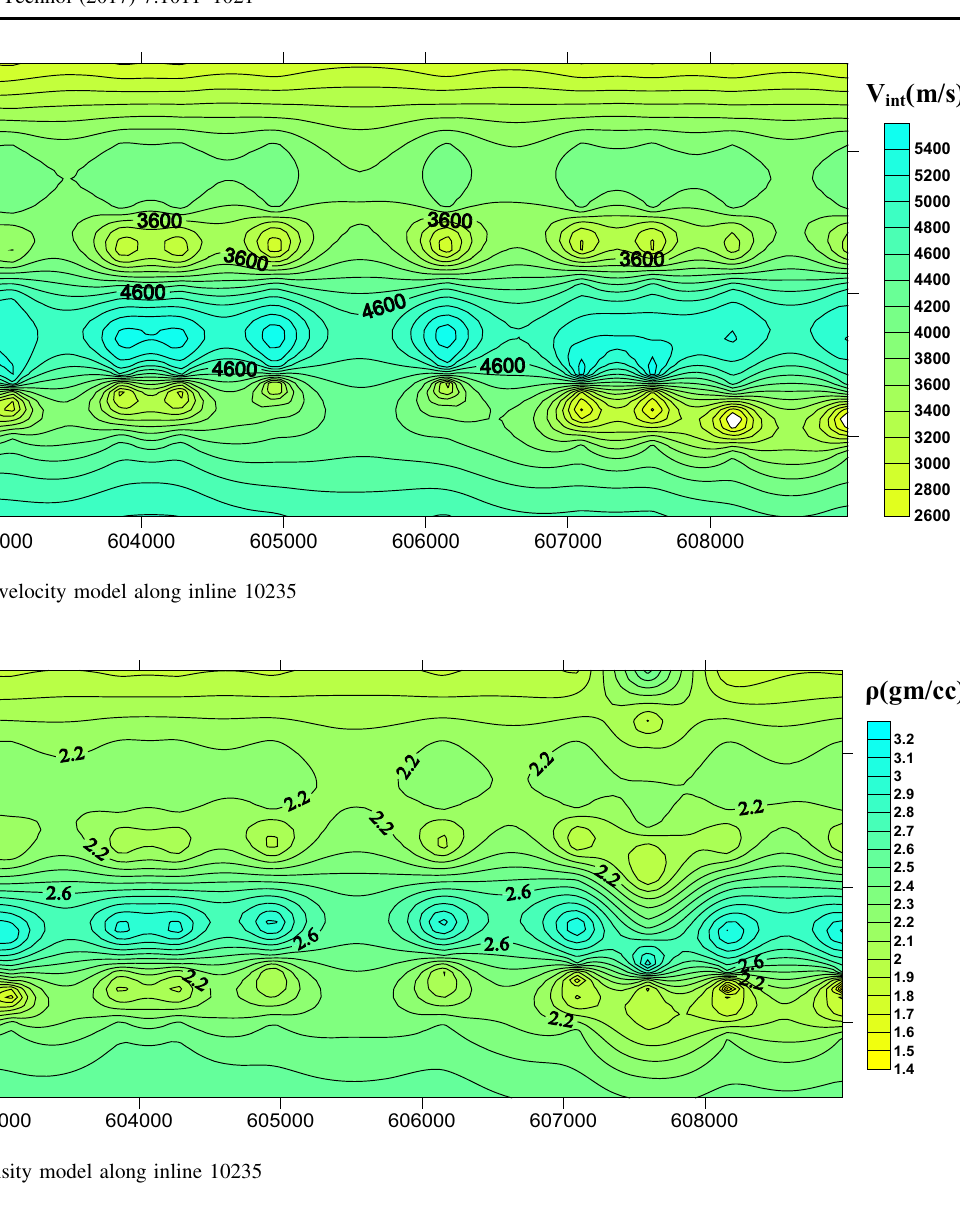
Fig. 12 2D bulk density model along inline 10235